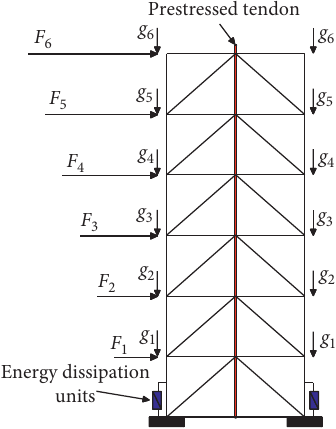
Figure 1: Mechanical model of the SC-CBF